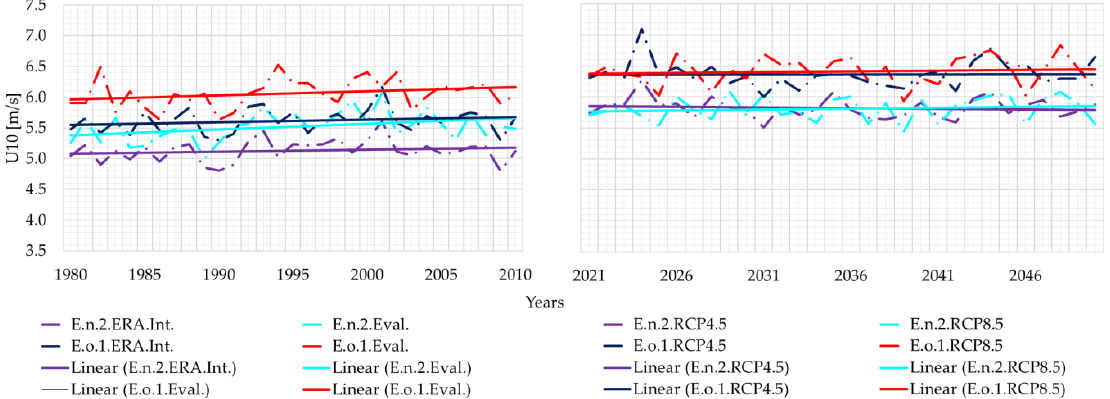
Figure A2. Annual averages of the wind speed at 10 m height for two of the most representative points located in shallow water (E.n.2) and in deep water (E.o.1) of Crimea Peninsula. ERA.Int and Eval data, time interval 1981–2010, RCP4.5 and RCP8.5 data, time interval 2021–2050.